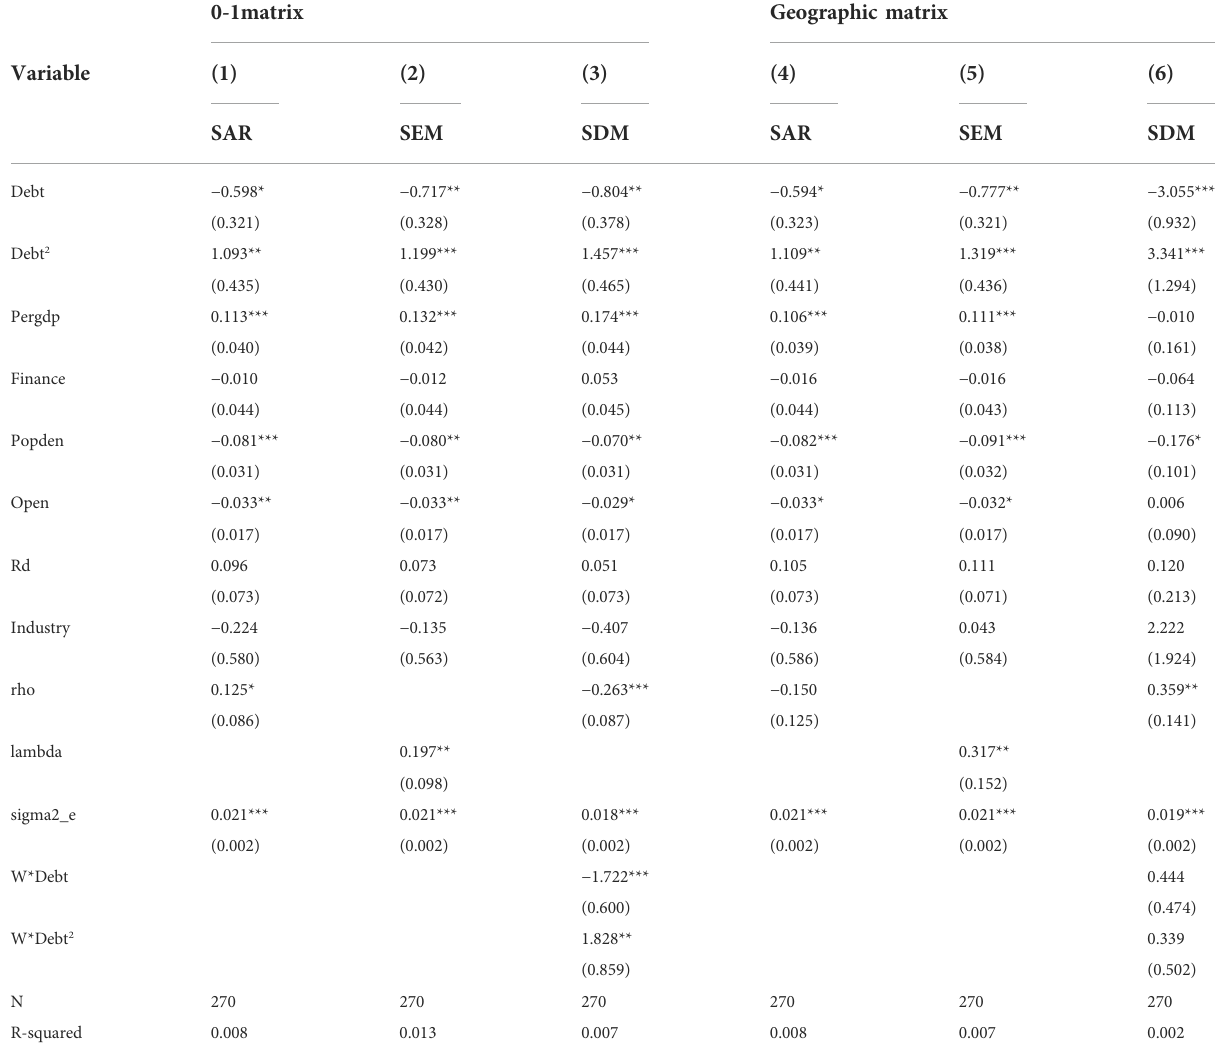
TABLE 5 Estimation results of the spatial econometric models.